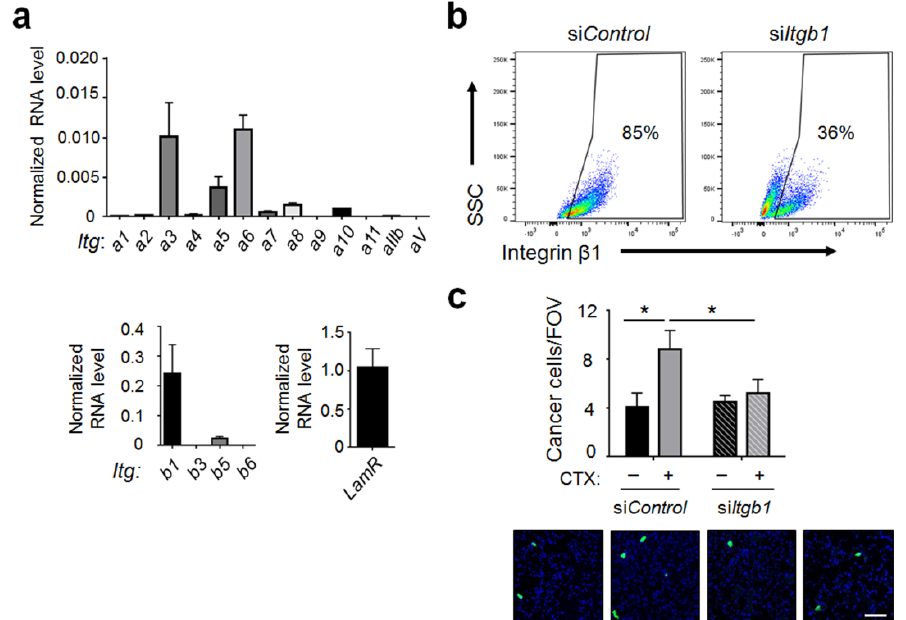
Figure 8. Integrin β1 knockdown in cancer cells reduced the effect of CTX. ( a ) mRNA levels of laminin receptor ( LamR ) and the indicated integrins ( Itg ) in tGFP-MVT1 cells were analyzed by reverse transcriptase coupled with quantitative polymerase chain reaction (RT-qPCR). Signals were normalized against glyceraldehyde 3-phosphate dehydrogenase ( Gapdh ) (from 4 independent experiments). ( b ) tGFP-MVT1 cells with Itgb1 knockdown (si Itgb1 ) or control knockdown (si Control ) were analyzed for their integrin β1 level on the cell surface by flow cytometry to estimate the knockdown efficiency. ( c ) tGFP-MVT1 cells with si Control or si Itgb1 knockdown were injected into mice with CTX (+) or vehicle (−) pre-treatment. Lung cancer cells per FOV at 3 h post-injection were analyzed ( n = 6–8 from 2 independent experiments). Bottom : Representative images. Scale bar, 50 μm. Bars indicate mean ± SEM; for panel ( c ), two-way ANOVA with post hoc Holm–Šídák correction; * p < 0.05.